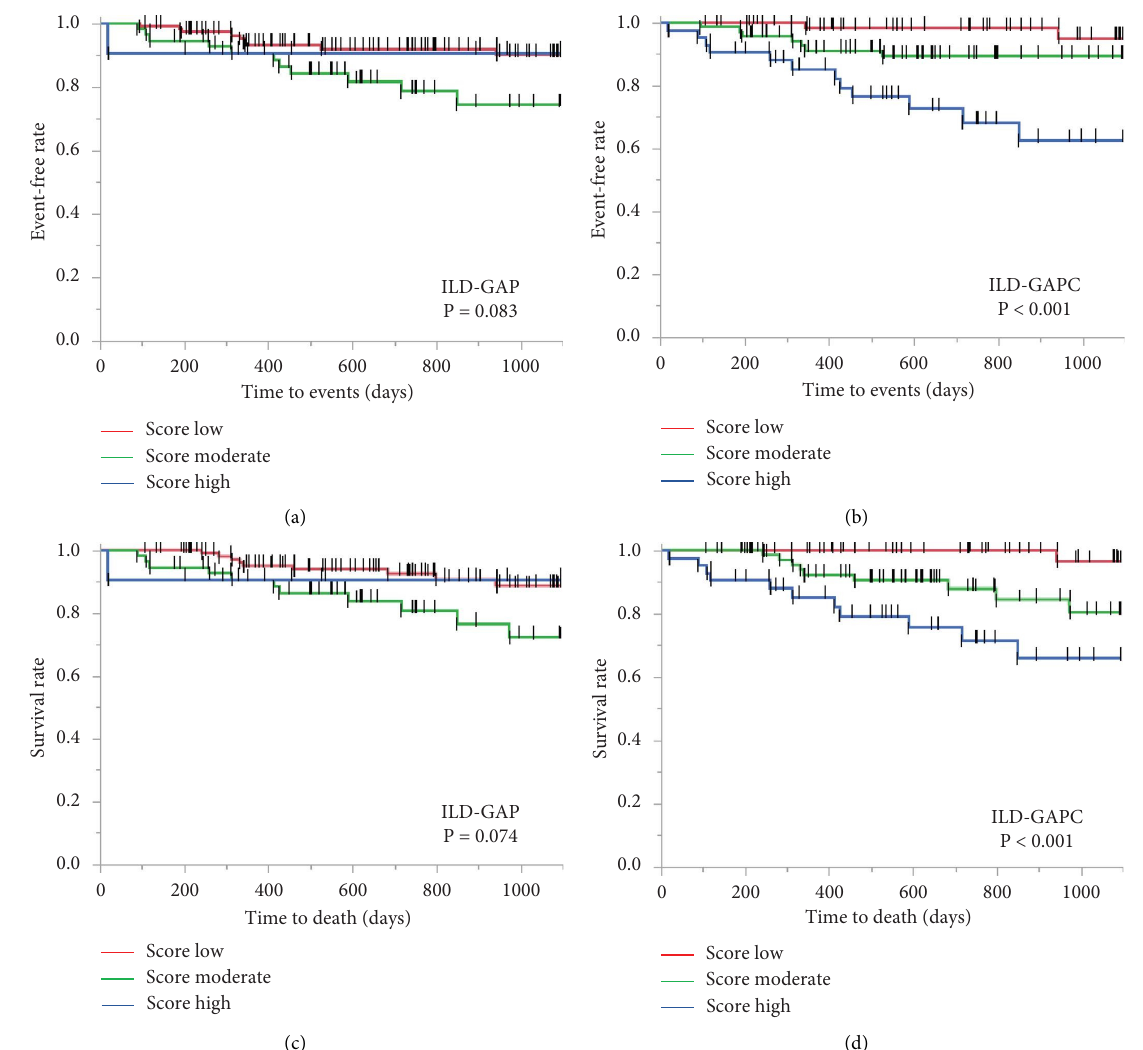
Figure 3: Comparison of the Kaplan–Meier curves between the ILD-GAP and ILD-GAPC models. (a) ILD-GAP P � 0 . 083, and (b) ILD- GAPC P < 0 . 001, for 3-year ILD events. (c) ILD-GAP P � 0 . 074, and (d) ILD-GAPC P < 0 . 001 for 3-year all-cause